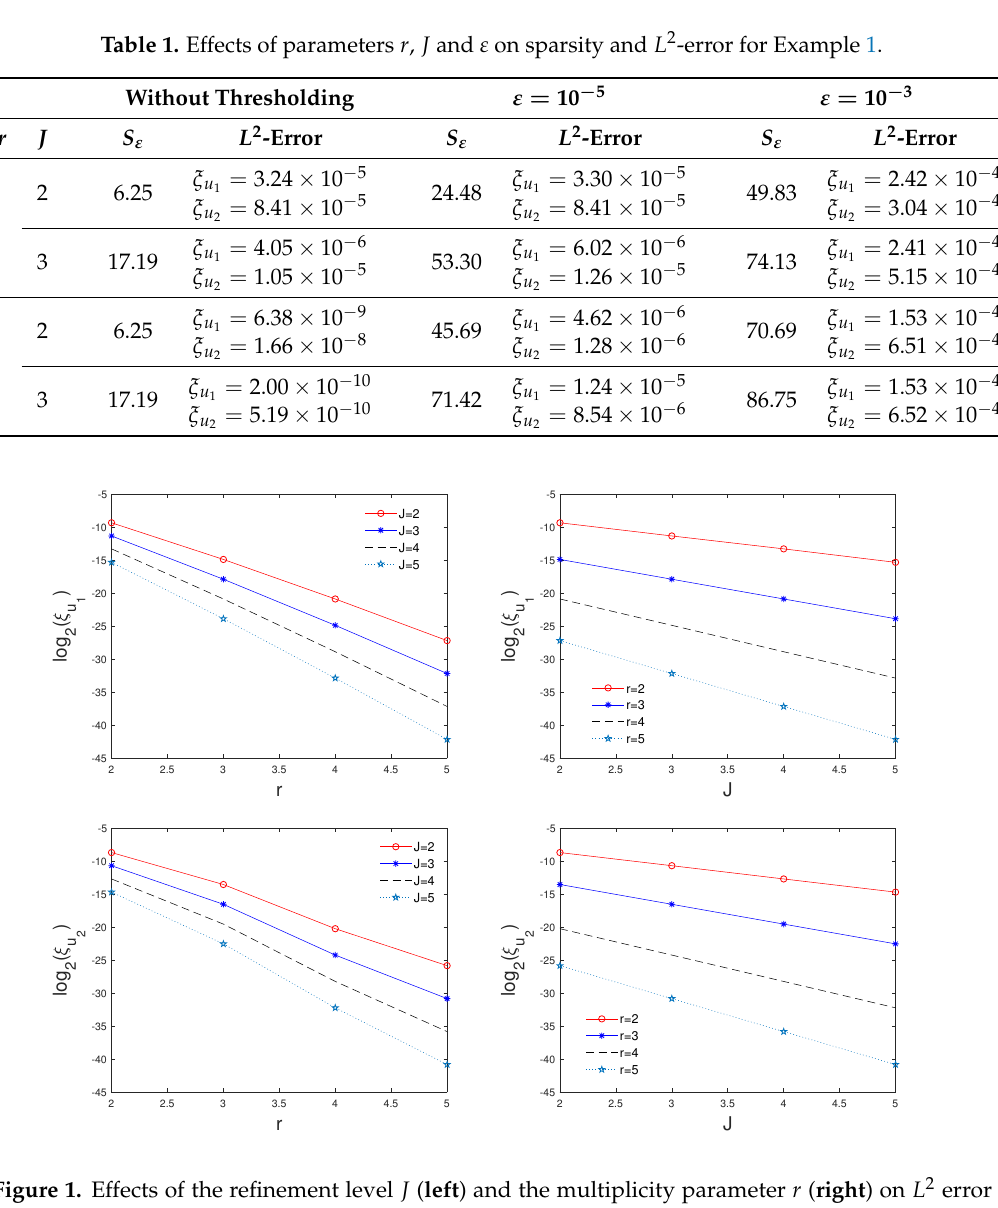
Figure 1. Effects of the refinement level J ( left ) and the multiplicity parameter r ( right ) on L 2 error when r = 5 and J = 2 for Example